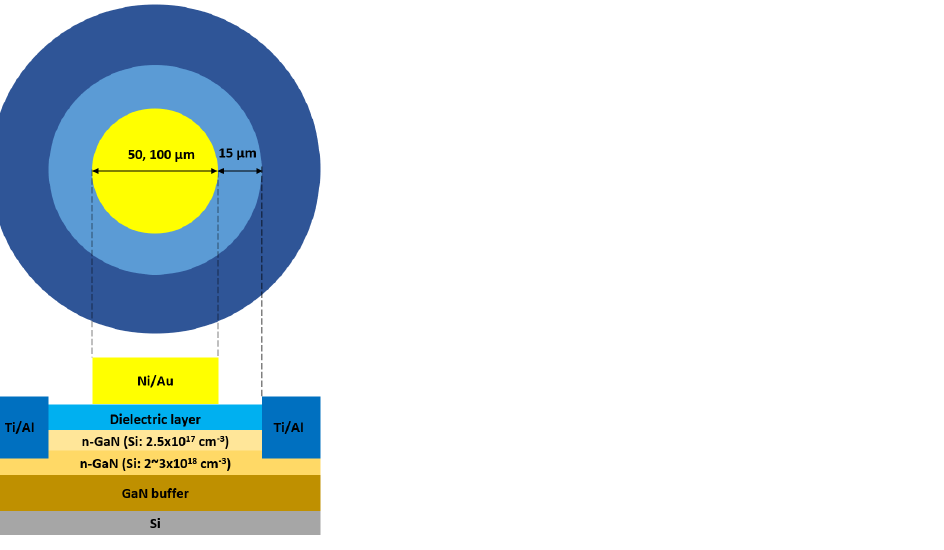
Figure 2. Cross-sectional schematic of the fabricated metal-insulator-semiconductor (MIS) capaci-